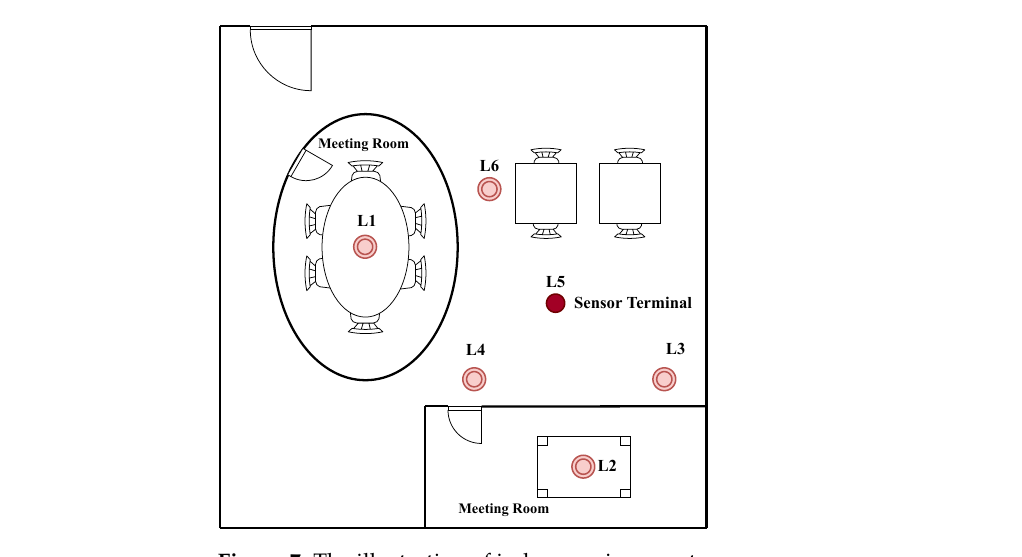
Figure 7. The illustration of indoor environment